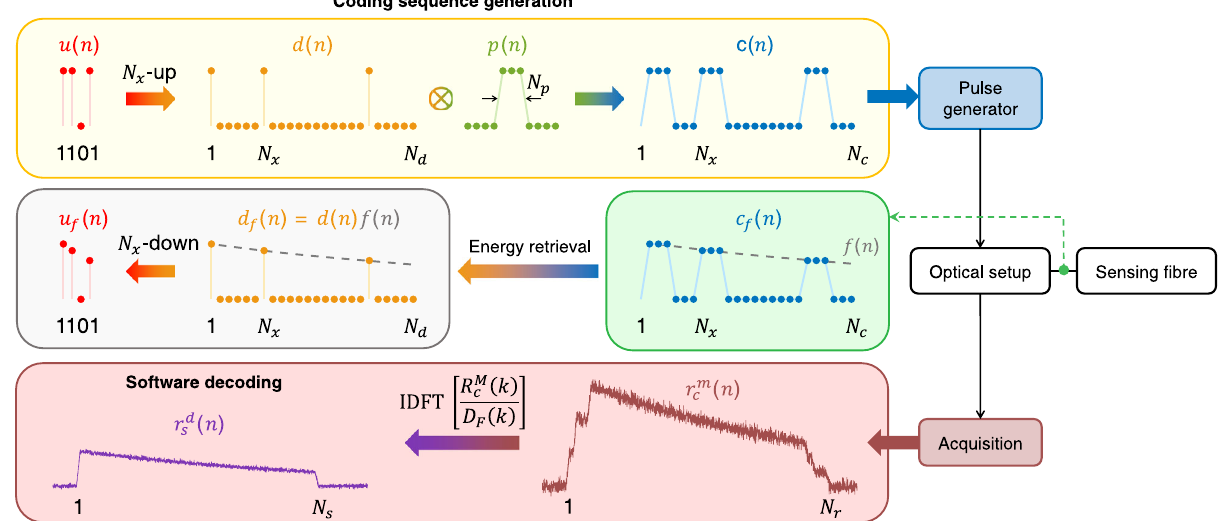
Fig. 1 Principle of the proposed coding and decoding process. The upper row shows the procedure to generate an N c -point discrete-time signal c ( n ) representing the digitally coded pulse sequence from a N u -point unipolar sequence u ( n ). This procedure involves three steps: (1) generate an N p -point single-pulse signal p ( n ) depending on the target spatial resolution Δ z , as N p = 2 Δ zf s / v g where v g is the pulse group velocity in the fi bre and f s is the sampling rate; (2) generate an N d -point sequence d ( n ) by performing an N x -point upsampling on u ( n ), so that N d = N x N u , where N x = N p for NRZ format and N x > N p for RZ format. Note that an RZ format must be used in given DOFS with a suf fi ciently long bit duration ( = N x / f s ) to get rid of undesired crosstalk effects that can be imposed by the acoustic inertial response in Brillouin sensing 51 or by the ampli fi ed spontaneous forward Raman scattering in ROTDR 57 ; and (3) linearly convolve d ( n ) with p ( n ), i.e. c ( n ) = d ( n ) ⊗ p ( n ), where the sign ⊗ denotes linear convolution so that the number of points in the code sequence c ( n ) is N c = N d + N p − 1. The king the energy of each pumiddle row shows the actual optical sequence launched into the sensing fi bre, denoted as c f ( n ), which exhibits an uneven amplitude envelop imposed by a function f ( n ) determined by the EDFA gain saturating response. By taking the energy of each pulse in c f ( n ), an N d -point sequence d f ( n ) that is equal to f ( n ) d ( n ) can be retrieved and is used for decoding. The bottom row shows the